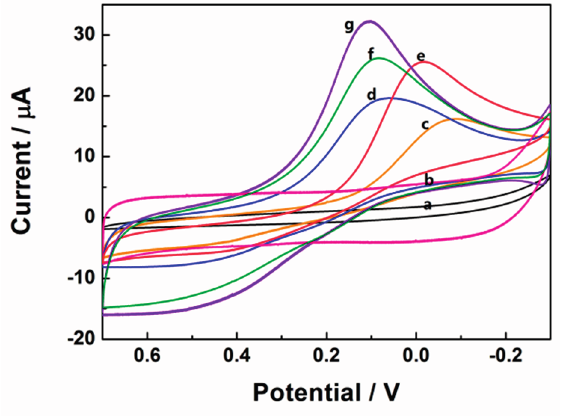
Figure 5. Cyclic voltammograms of (a) bare GCE; (b) rGSs/GCE; (c) Au/GCE; (d) Pt/GCE; (e) Pt-Au/GCE and (f) Pt/rGSs/GCE; (g) Pt-Au/rGSs/GCE in 0.1 M PBS (pH = 7.4) containing 0.1 mM H 2 O 2 at a scan rate of 100 mV·s − 1